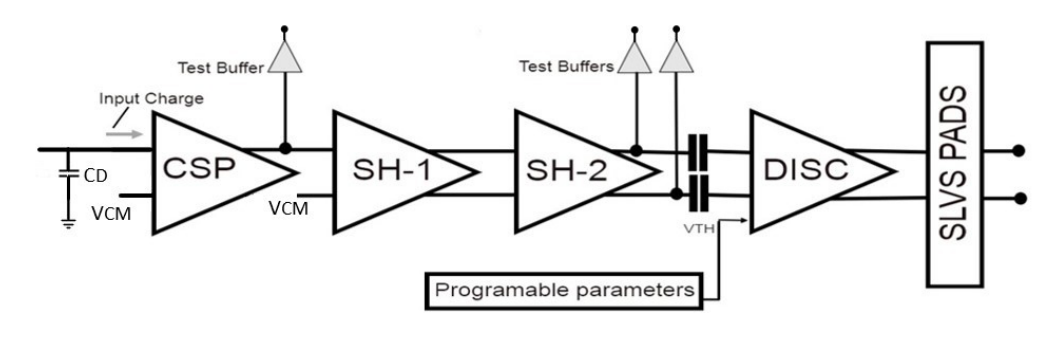
Figure 1. Generic block diagram of one channel of the FEE chip.